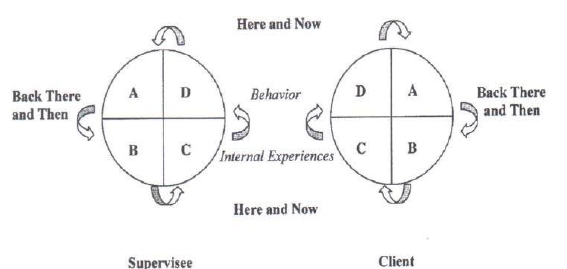
Figure 32: Mapping the Field (Sills & Mazzetti 2009 p. 309)